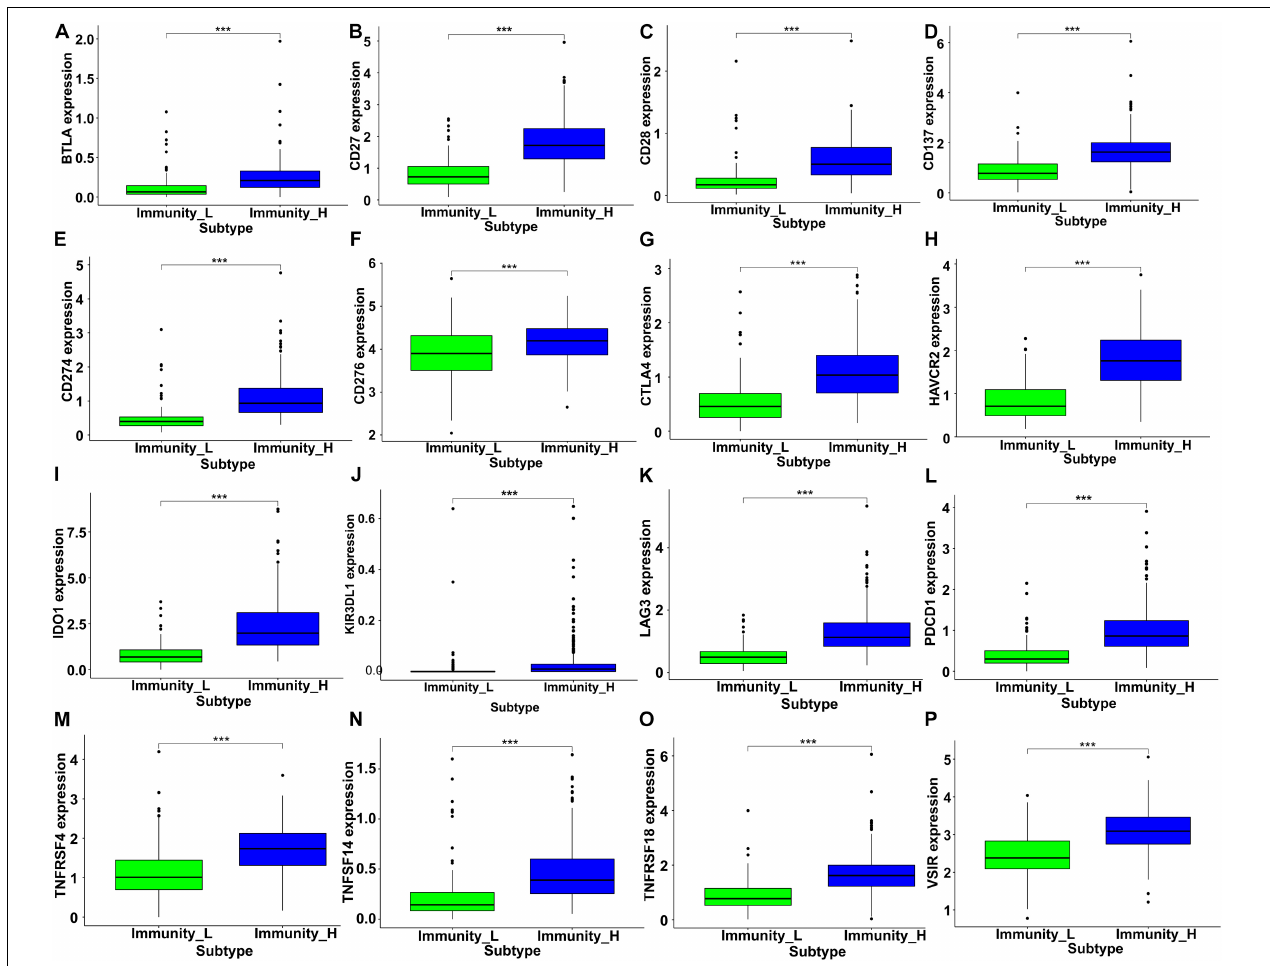
FIGURE 6 | The expression levels of immune checkpoint related genes in different immunity groups of colon cancer. The gene expression of (A) BTLA, (B) CD27, (C) CD28, (D) CD137, (E) CD274, (F) CD276, (G) CTLA4, (H) HAVCR2, (I) IDO1, (J) KIR3DL1, (K) LAG3, (L) PDCD1, (M) TNFRSF4, (N) TNFSF14, (O) TNFRSF18, and (P) VSIR were significantly higher in the high immunity group (*** P <